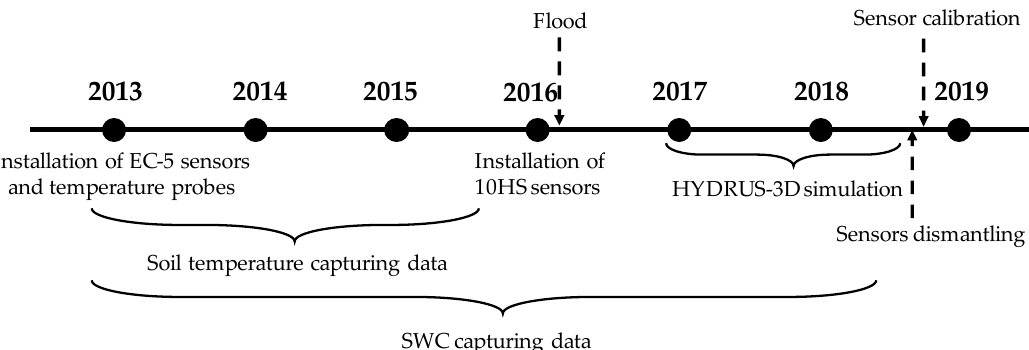
Figure 2. Temporal sequence where the most relevant moments are indicated. Recording of soil temperature ended in early 2016 when the setup was damaged by flood. The soil water content (SWC) measurements analyzed in this paper focus on the irrigation seasons of 2017 and 2018, which were also simulated with HYDRUS. At the end of this period, all 10HS sensors were dismantled and calibrated in laboratory.